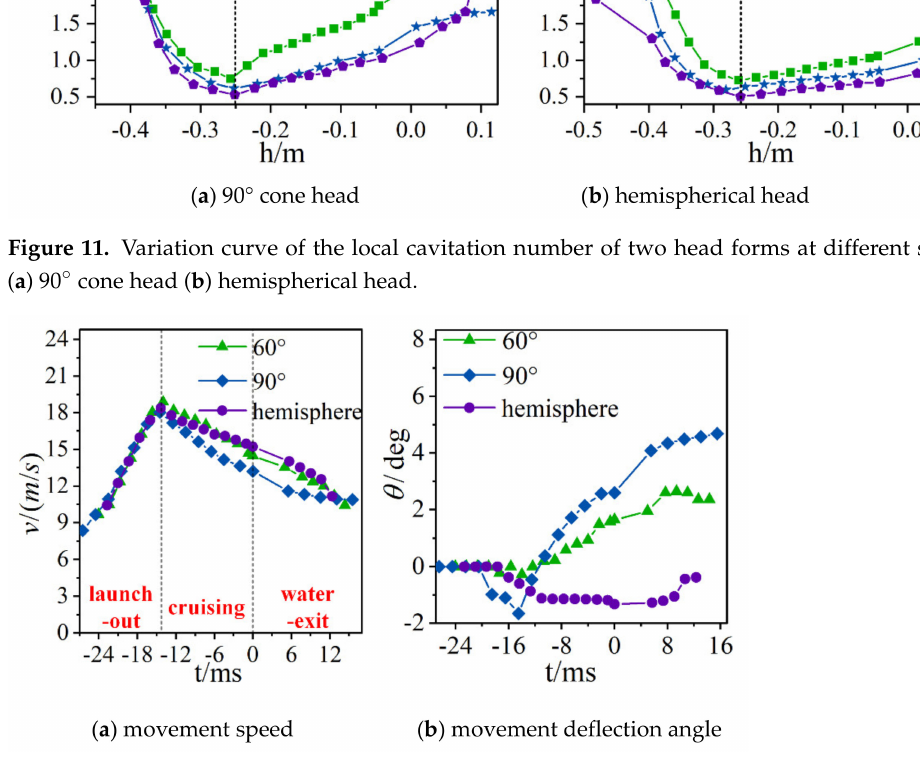
Figure 12. Variation curve of motion parameters of three head-shaped projectiles. ( a ) movement speed ( b ) movement deflection